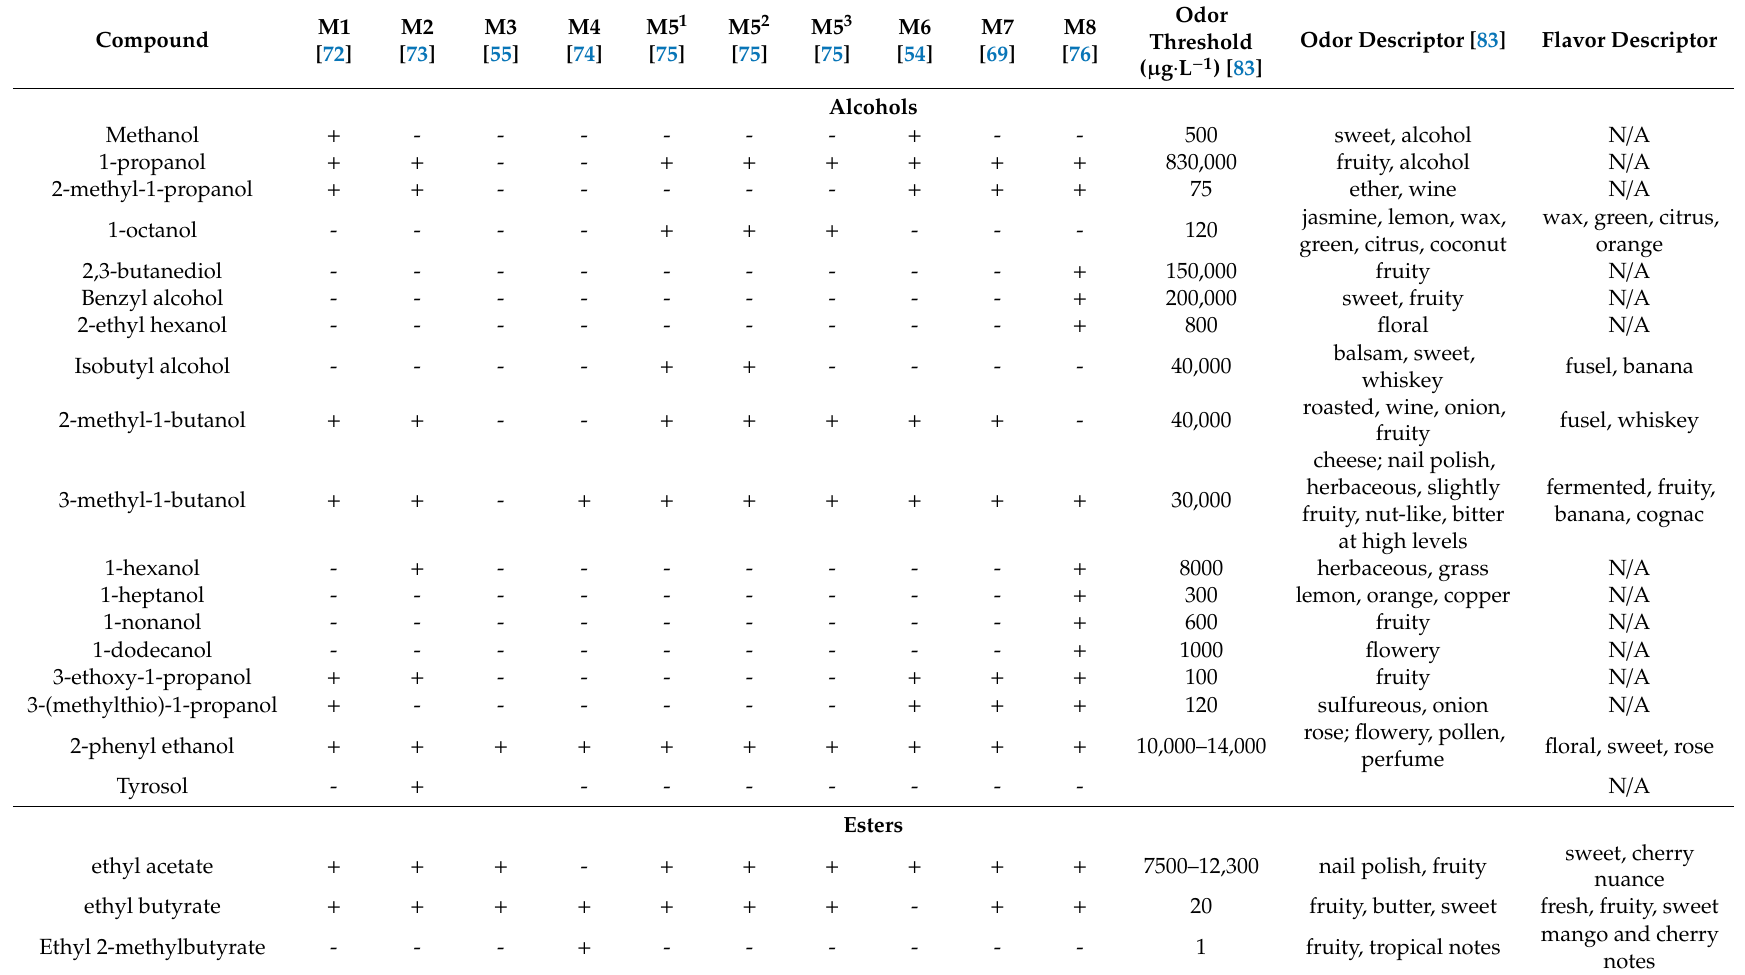
Table 3. Odor threshold and odor descriptor of volatile compounds found in di ff erent mead